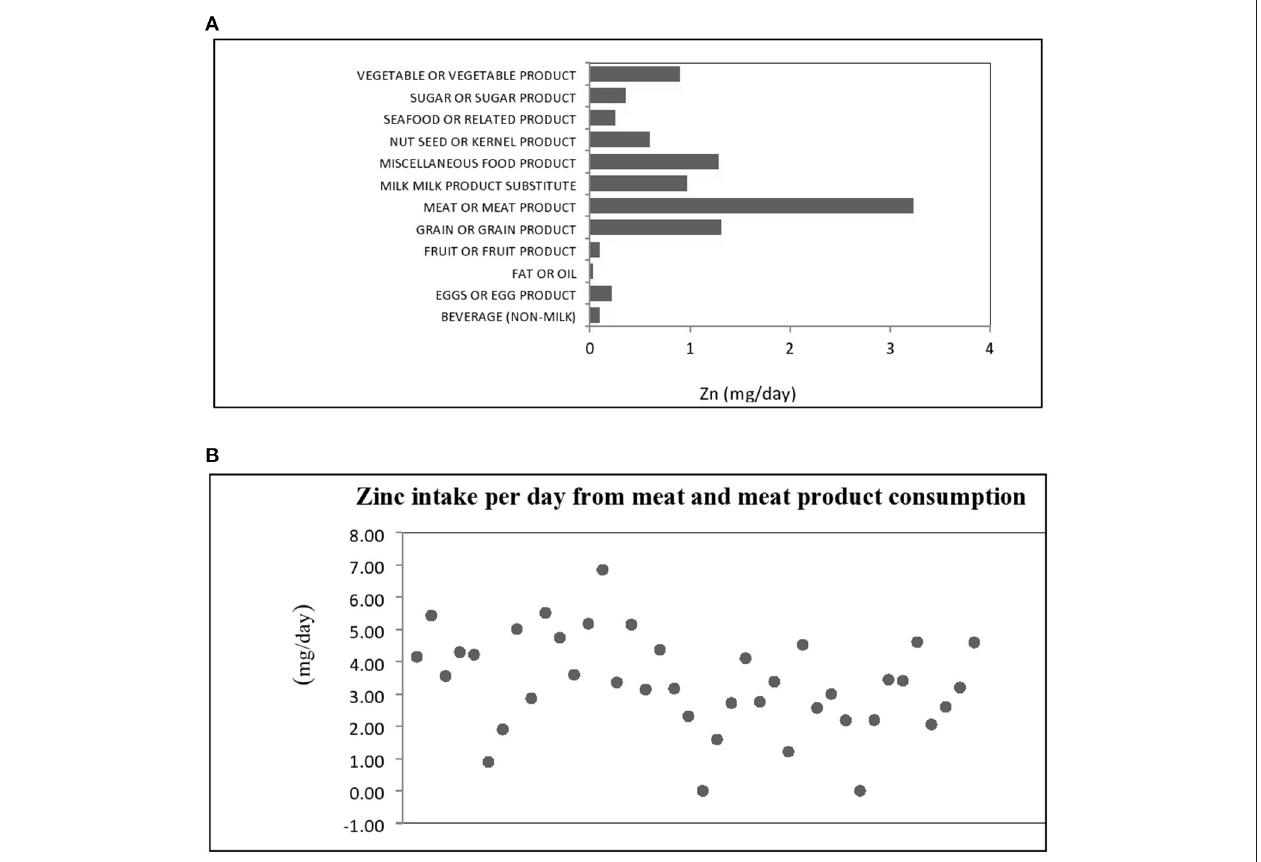
FIGURE 1 | (A) Dietary sources of zinc intake by food groups and (B) Distribution of zinc intake for meat and meat product in hemodialysis patients.